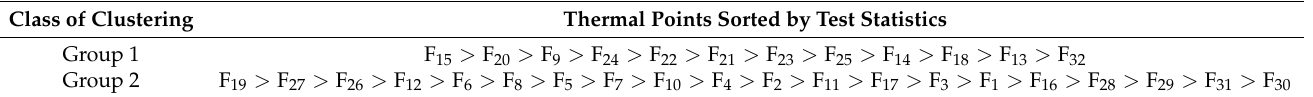
Table 2. The analysis result of optimization algorithm for the first machine tool. Class of Clustering Thermal Points Sorted by Test Statistics